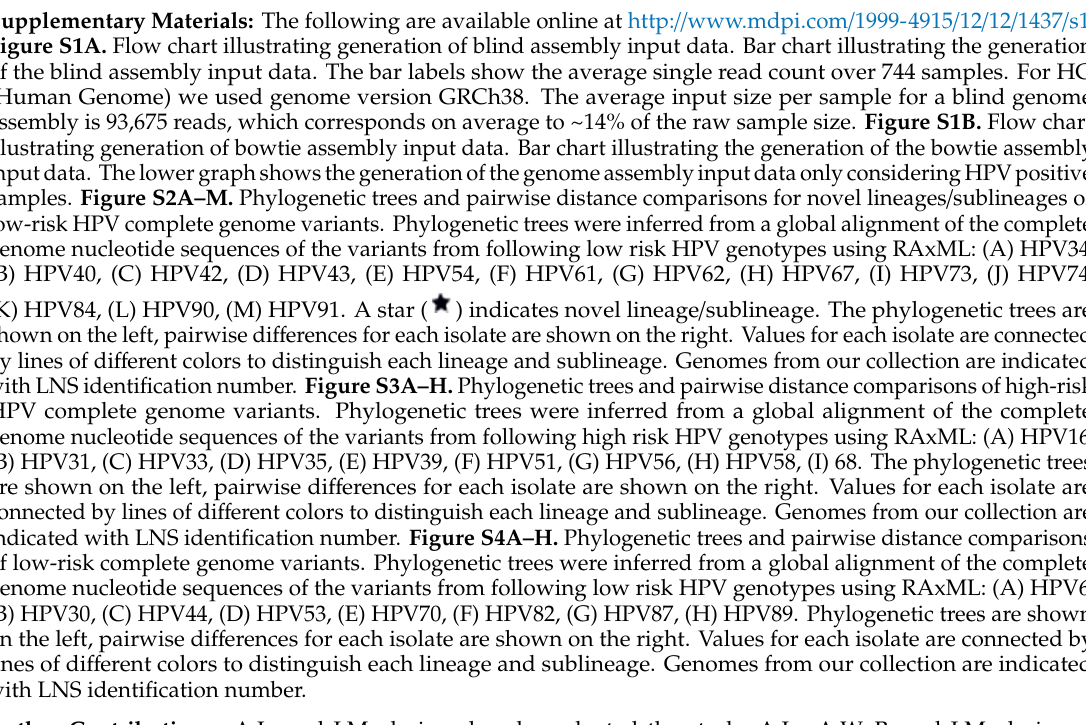
Figure S1A. Flow chart illustrating generation of blind assembly input data. Bar chart illustrating the generation of the blind assembly input data. The bar labels show the average single read count over 744 samples. For HG (Human Genome) we used genome version GRCh38. The average input size per sample for a blind genome assembly is 93,675 reads, which corresponds on average to ~14% of the raw sample size. Figure S1B. Flow chart illustrating generation of bowtie assembly input data. Bar chart illustrating the generation of the bowtie assembly inputdata. ThelowergraphshowsthegenerationofthegenomeassemblyinputdataonlyconsideringHPVpositive samples. Figure S2A–M. Phylogenetic trees and pairwise distance comparisons for novel lineages / sublineages of low-risk HPV complete genome variants. Phylogenetic trees were inferred from a global alignment of the complete genome nucleotide sequences of the variants from following low risk HPV genotypes using RAxML: (A) HPV34, (B) HPV40, (C) HPV42, (D) HPV43, (E) HPV54, (F) HPV61, (G) HPV62, (H) HPV67, (I) HPV73, (J) HPV74, (K) HPV84, (L) HPV90, (M) HPV91. A star ( ) indicates novel lineage / sublineage. The phylogenetic trees are shown on the left, pairwise di ff erences for each isolate are shown on the right. Values for each isolate are connected by lines of di ff erent colors to distinguish each lineage and sublineage. Genomes from our collection are indicated with LNS identification number. Figure S3A–H. Phylogenetic trees and pairwise distance comparisons of high-risk HPV complete genome variants. Phylogenetic trees were inferred from a global alignment of the complete genome nucleotide sequences of the variants from following high risk HPV genotypes using RAxML: (A) HPV16, (B) HPV31, (C) HPV33, (D) HPV35, (E) HPV39, (F) HPV51, (G) HPV56, (H) HPV58, (I) 68. The phylogenetic trees are shown on the left, pairwise di ff erences for each isolate are shown on the right. Values for each isolate are connected by lines of di ff erent colors to distinguish each lineage and sublineage. Genomes from our collection are indicated with LNS identification number. Figure S4A–H. Phylogenetic trees and pairwise distance comparisons of low-risk complete genome variants. Phylogenetic trees were inferred from a global alignment of the complete genome nucleotide sequences of the variants from following low risk HPV genotypes using RAxML: (A) HPV6, (B) HPV30, (C) HPV44, (D) HPV53, (E) HPV70, (F) HPV82, (G) HPV87, (H) HPV89. Phylogenetic trees are shown on the left, pairwise di ff erences for each isolate are shown on the right. Values for each isolate are connected by lines of di ff erent colors to distinguish each lineage and sublineage. Genomes from our collection are indicated with LNS identification